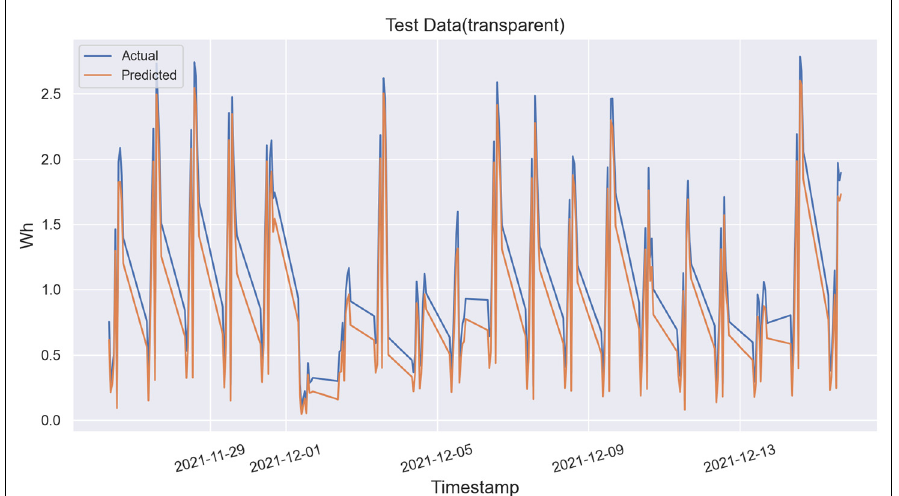
Figure 6. Transformers model test result visualization of Transparent type module.